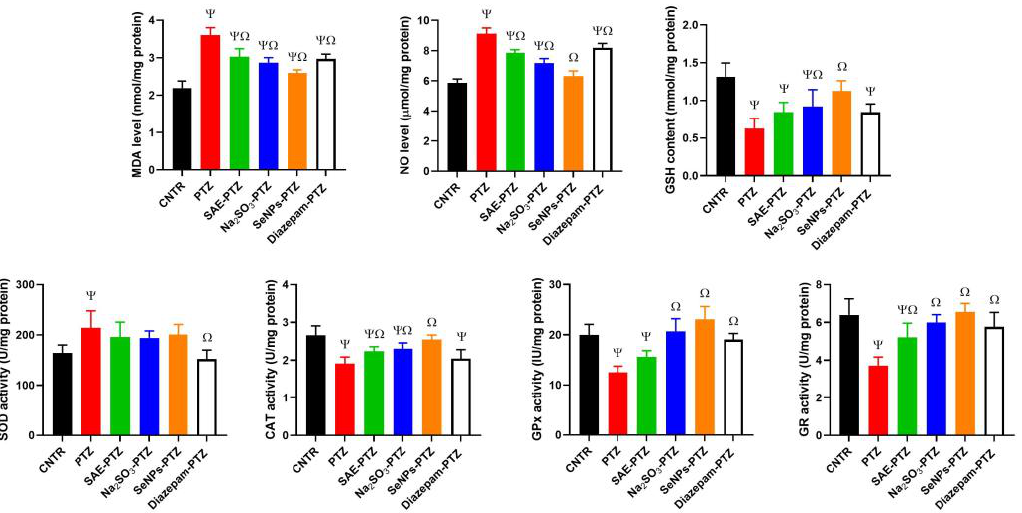
Figure 3. Antioxidant effects of oral administration of Syzygium aromaticum extract (SAE), sodium selenite (Na 2 SeO 3 ), and green synthetized SeNPs using SAE (SAE-SeNPs) indicated by the cortical levels of malondialdehyde (MDA), nitric oxide (NO), glutathione (GSH), superoxide dismutase (SOD), catalase (CAT), glutathione peroxidase (GPx), and glutathione reductase (GR) against pentylenetetrazol (PTZ)-induced neuronal oxidative stress ( n = 8). Ψ and Ω indicate significant differences ( p < 0.05) compared with the control and PTZ-exposed groups, respectively. All values are presented as the mean ± standard deviation (SD).